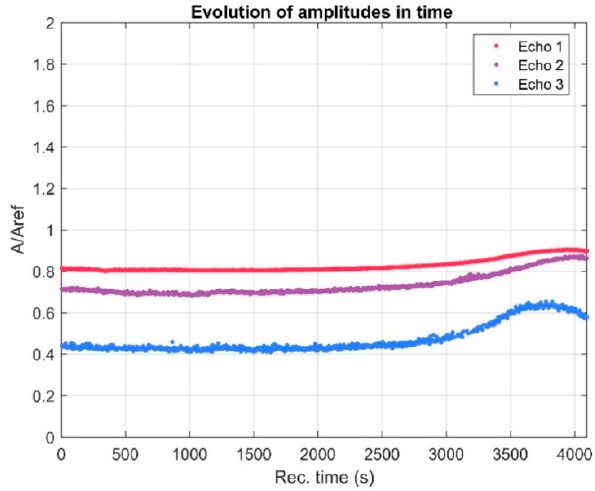
Figure 2. Relative amplitudes evolution vs. recording moments.